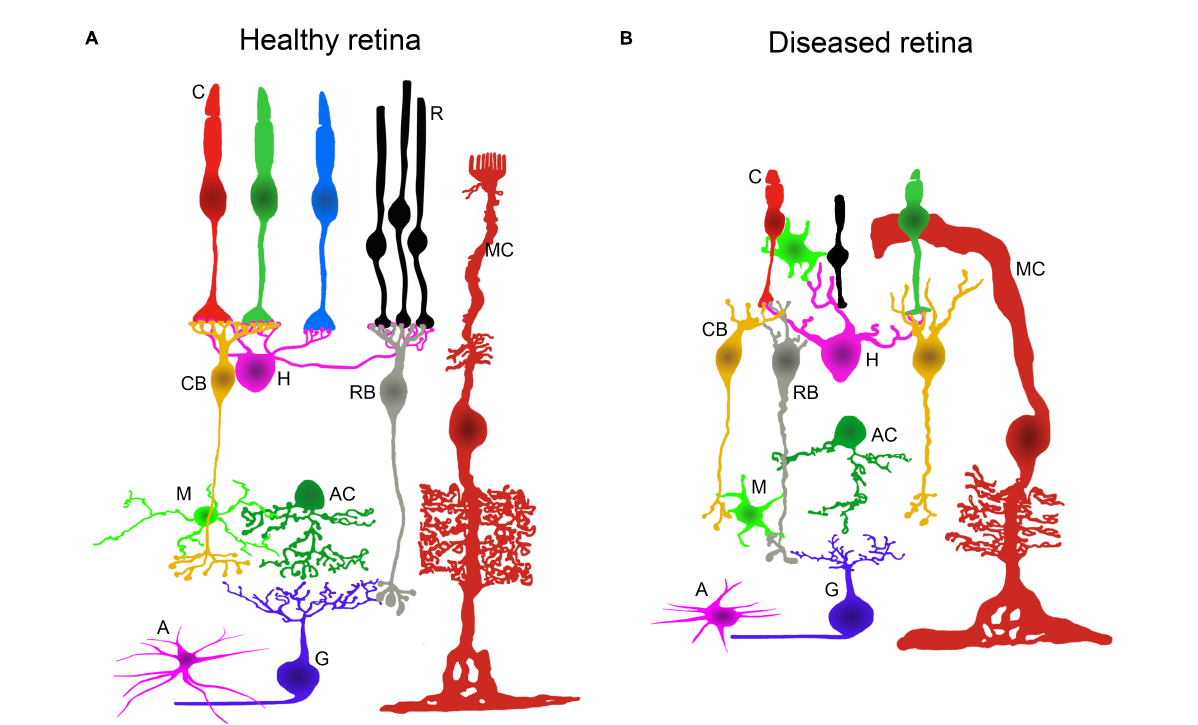
FIGURE1 Retinal alterations associated to IRDs. Schematic representation of the retinal neurons and glial cells in healthy and diseased retinas. (A) Normal morphology and layered architecture of the mammalian retina in physiological conditions. (B) During retinal neurodegenerative processes, changes in morphology and connectivity take place. There is a loss of rods and major morphological alterations in cones. The dendrites from horizontal and bipolar cells degenerate. There is a generalized retraction and loss of axons, dendrites, and synaptic connections in the inner retinal neurons. Müller cells, microglia, and astrocytes display an activated state and undergo morphological changes. C: cone photoreceptor; R: rod photoreceptor; MC: Müller cell; CB: cone bipolar cell; H: horizontal cell; RB: rod bipolar cell; M: microglial cell; AC: amacrine cell; A: astrocyte; G: ganglion